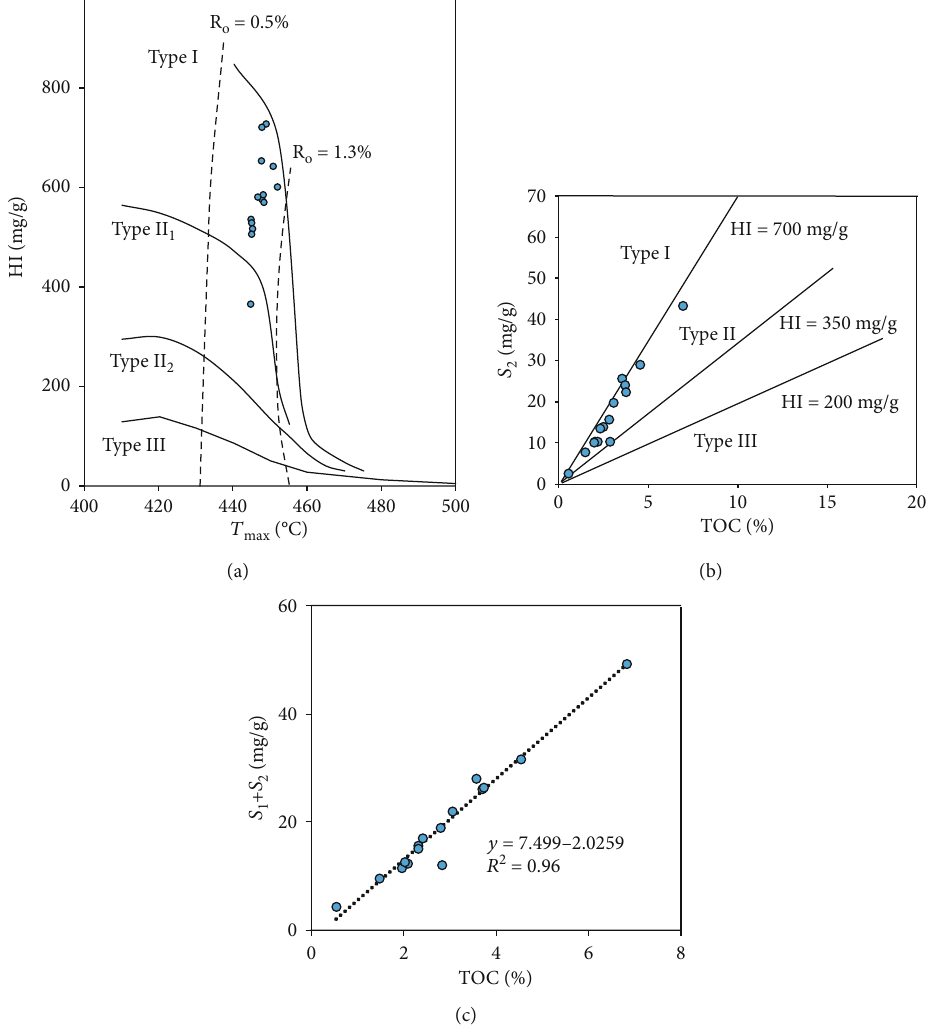
Figure 2: Cross-plots of the bulk geochemical results. (a) Hydrogen index (HI) versus Tmax relationship for the shale samples from the K qn Formation. (b) Cross-plots of TOC versus S 2 . (c) Cross-plots of TOC versus S 1 + S 2 2 1